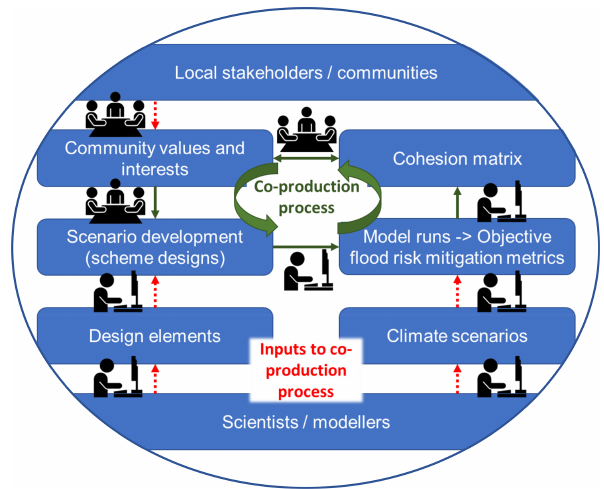
Figure 3. Schematic representation of the proposed co-production process to plan and develop managed realignment schemes. Some workflows are completed through traditional academic knowledge production (researcher working on computer), whereas other work- flows will be completed through collaboration with stakeholders, communities, and researchers (three people sitting around a table). The core workflow of the co-production process is indicated by full green linkages, while input into the co-production process is indi- cated by dashed red